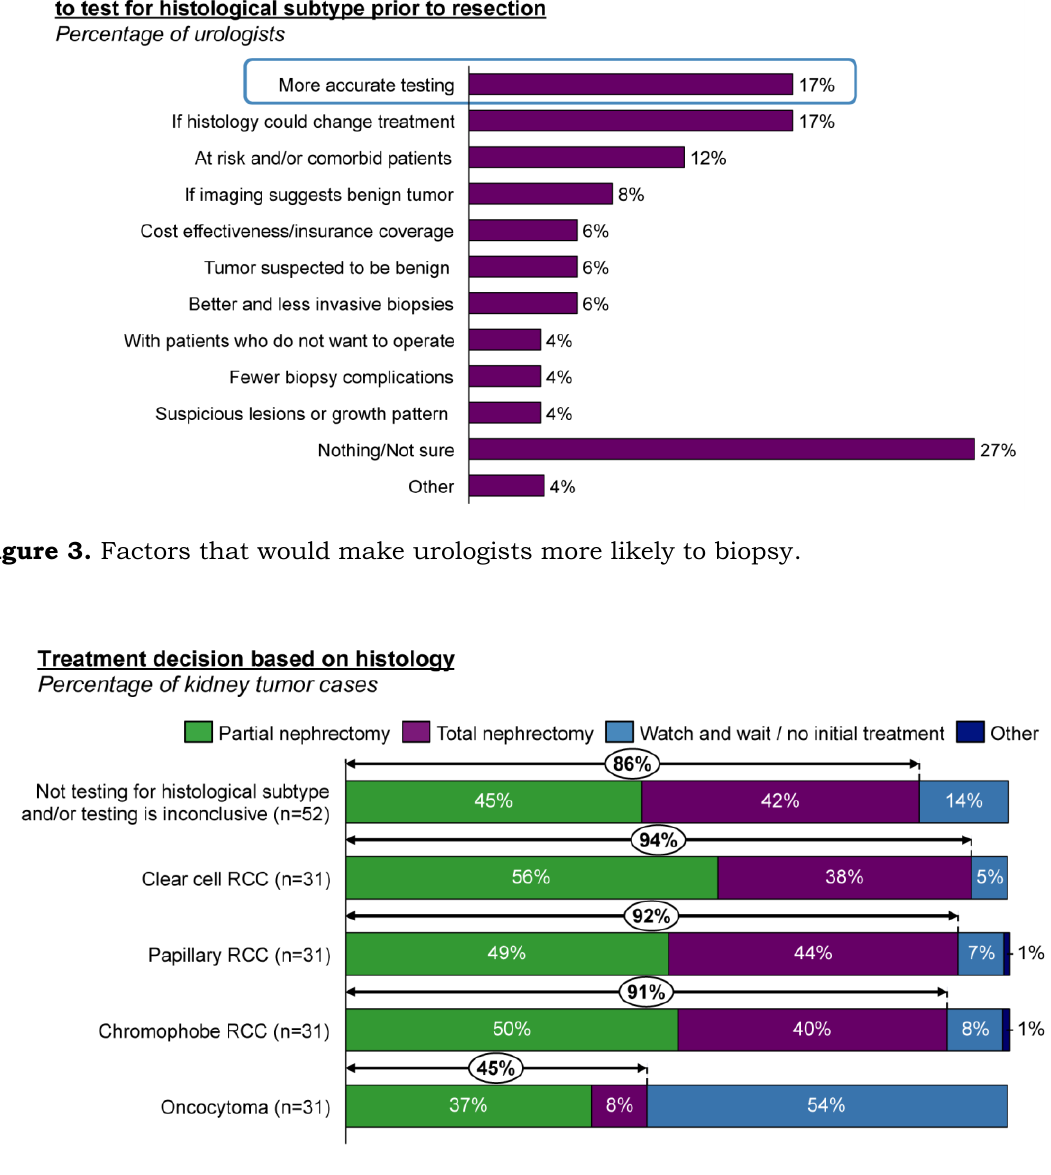
Figure 4. Current histological drivers of decision to resect kidney tumors.